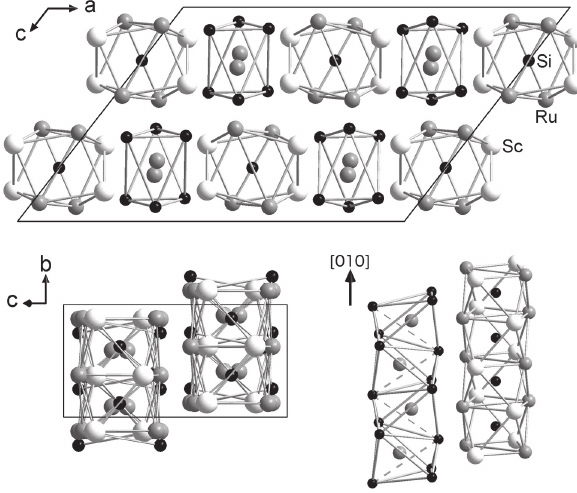
Table 1: Data collection and handling.